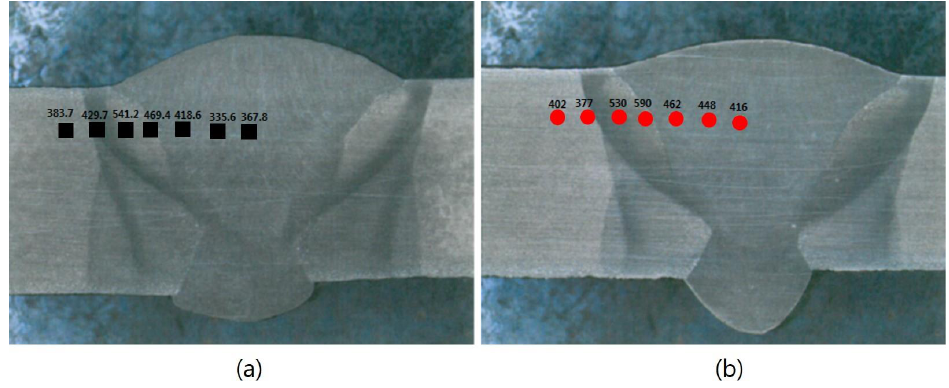
Figure 2. Hardness test results in butt joint with variation of shielding gas: ( a ) O 2 2%, 14.0~15.5 kJ/cm; ( b ) CO 2 5%, 12.8~17.7 kJ/cm.